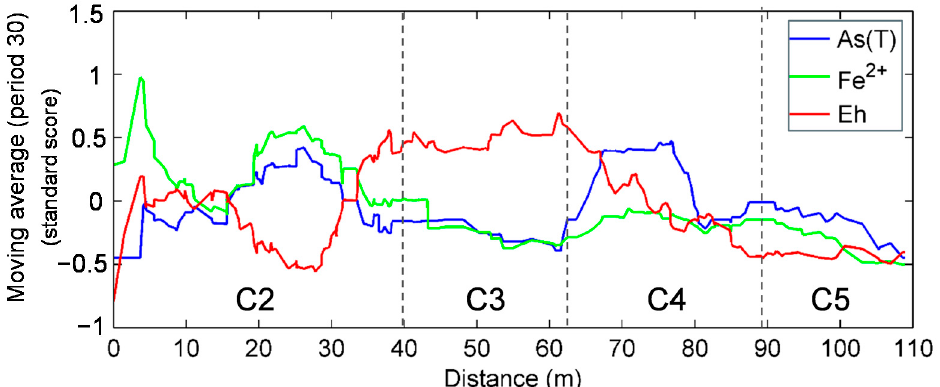
Figure 6. Variation trends of the As and Fe 2+ concentrations and Eh values across different groundwater systems. Concentrations were standardized and then smoothed using a moving average filter with a period of 30.